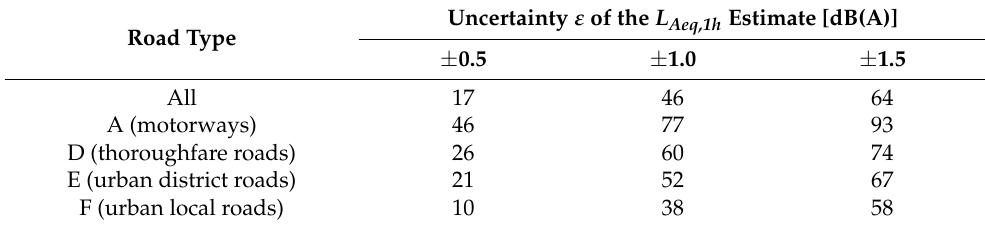
Table 2. Percentage of ST values ≤ 15 min for each road type and uncertainty ε .